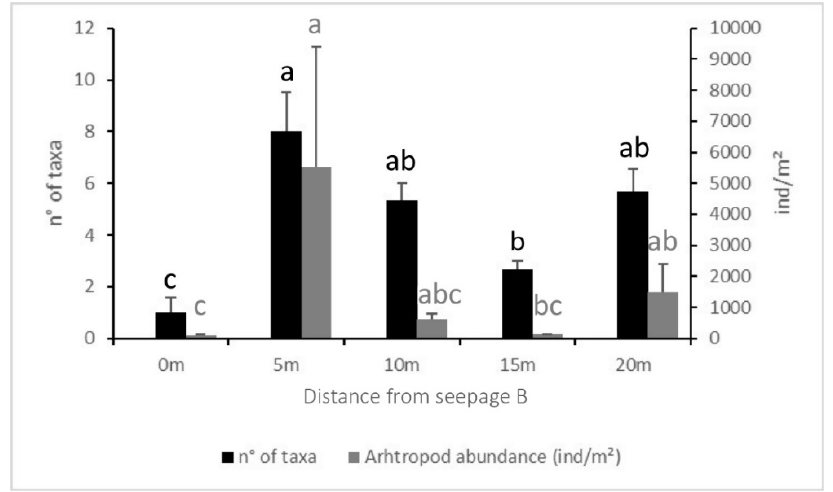
Figure 7. Average and Standard Error of the number of taxa and the number of individuals per m 2 found along the transect at 0 m (soil surrounding seepage B), 5 m, 10 m, 15 m and 20 m from seepage B. Di ff erent letters above bars mean significant di ff erences within transects ( p ≤ 0.01). A higher abundance of Collembola was found in site A, but no significant di ff erences were found along the transect (Figure 8b). In site B, their abundance was lower than in site A but with significant di ff erences among the transect ( p ≤ 0.01): more Collembola were found at 5 m and 20 m than at 15 m from